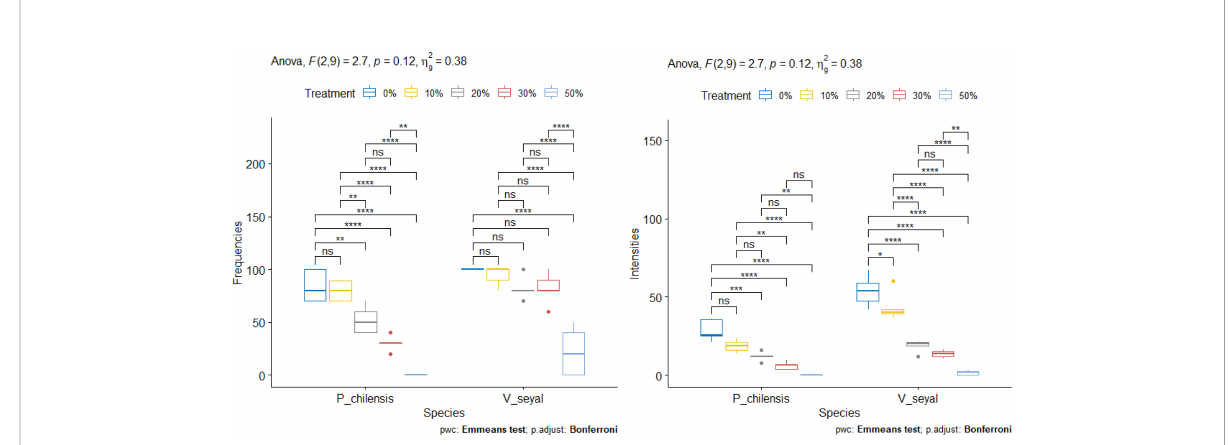
FIGURE 13 Frequencies of mycorrhization (FM) and intensities of mycorrhization (IM) according to the rate of organic matter. “ * ” = Statistically signi fi cant difference at 5%, “ ** ” = Statistically signi fi cant difference at 1% and “ *** ” = Statistically signi fi cant difference 0.1% and *ns* = non-signi fi cant.